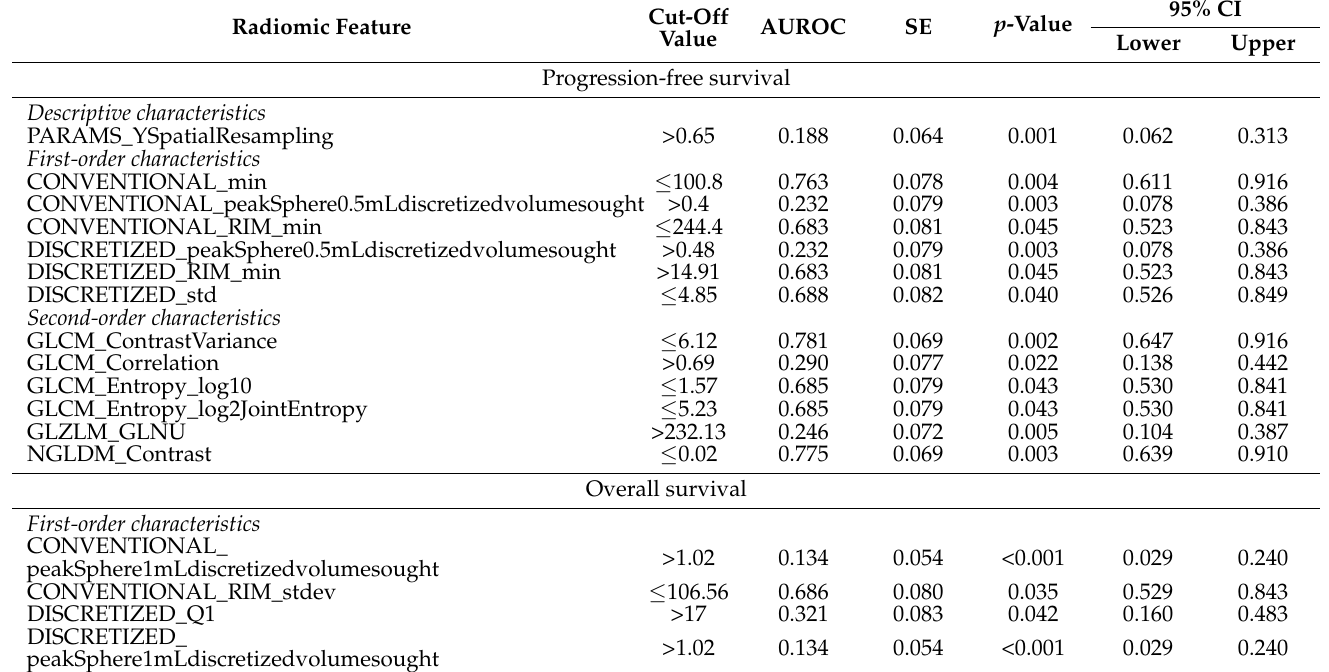
Figure 5. ROC curves of the significant radiomics. Sections ( A , B ) show the radiomics with significance for progression-free survival; ( C , D ) show the radiomics with significance for overall survival above the median. Table 2. The cut-off value for the significant radiomic